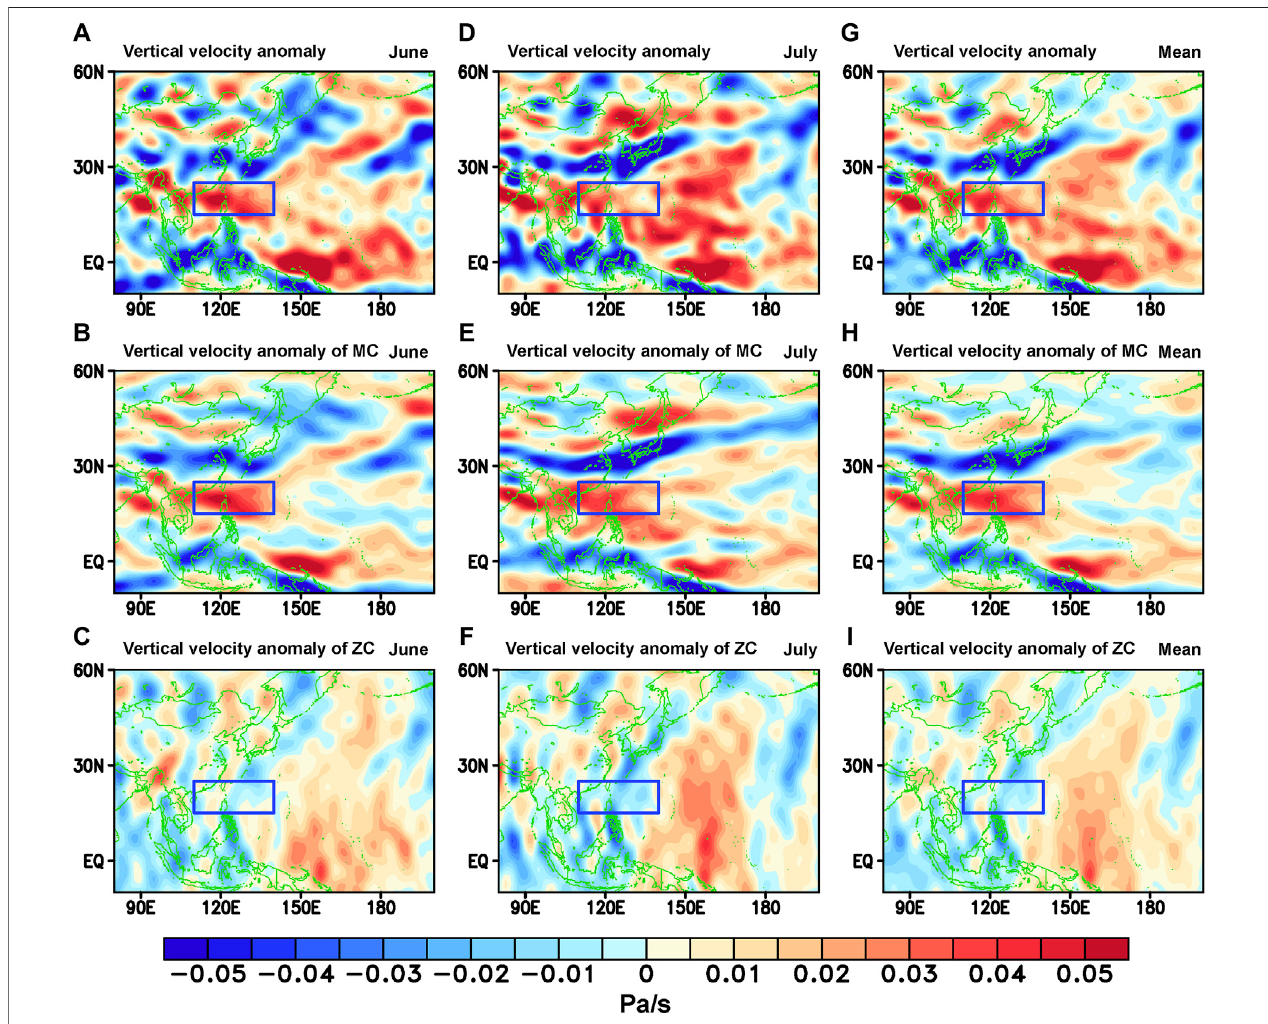
FIGURE 2 | (A) Horizontal distribution of the vertical velocity anomaly at 500 hPa in June 2020 derived from the ensemble means of fi ve reanalysis data sets (shading, Pa s − 1 ). (B) and (C) Same as (A) but for the vertical velocity anomalies of meridional circulation (MC) and zonal circulation (ZC), respectively. (D – F) and (G – I) Same as (A – C) but for the results in July and the mean of June and July, respectively. The blue box in each plot indicates the region of the western part of the WPSH. Anomalies were computed based on the climatology of 1981 – 2010. The decomposition of the vertical velocity anomaly was based on the three-pattern decomposition of the global atmospheric circulation (3P-DGAC)